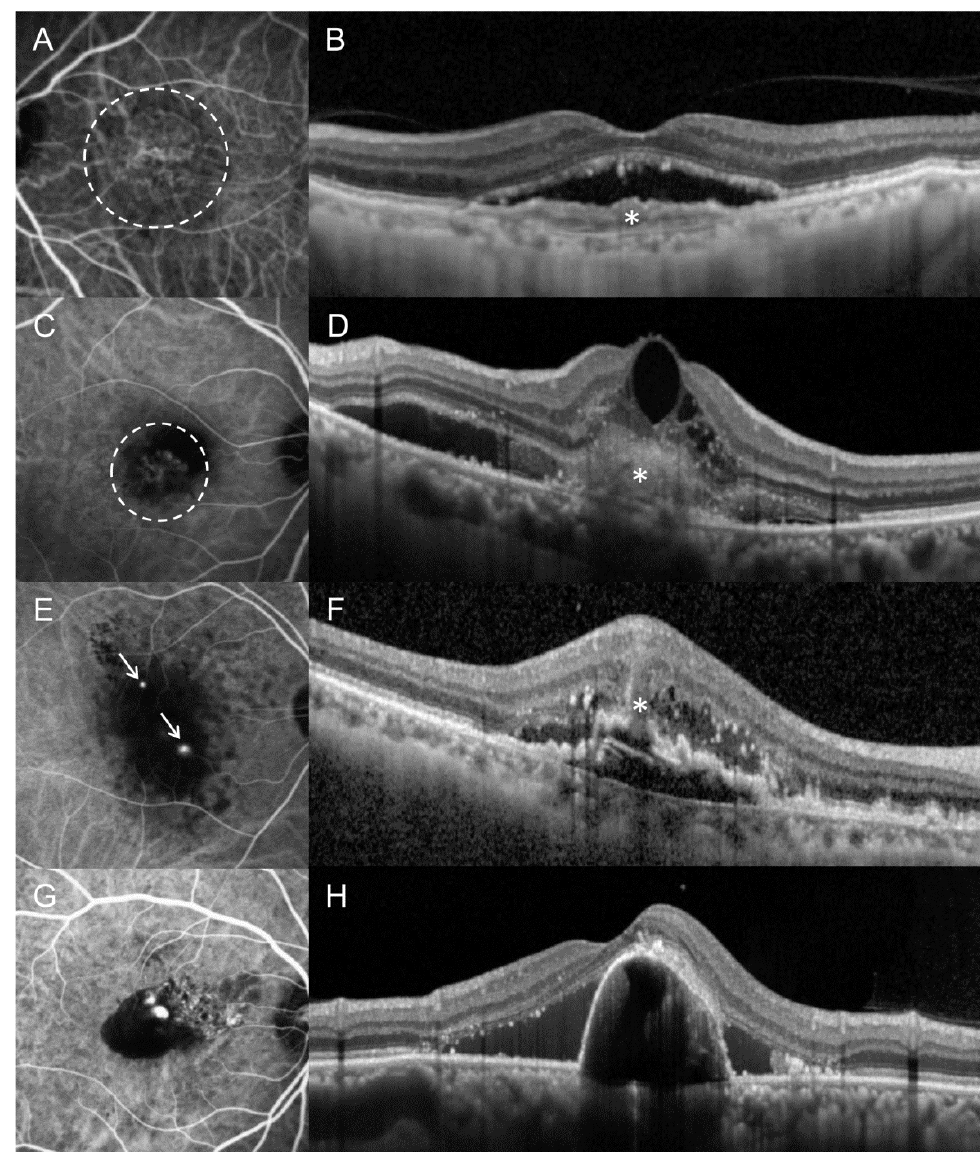
Figure 1. Representative indocyanine green angiography (ICGA) ( A , C , E , G ) and optical coherence tomography (OCT) ( B , D , F , H ) images showing representative cases of type 1 macular neovascularization (MNV) ( A , B ), type 2 MNV ( C , D ), type 3 MNV ( E , F ), and polypoidal choroidal vasculopathy (PCV) ( G , H ). In type 1 MNV, a neovascular complex, observed on ICGA ( A , dashed circle), is confined to the sub-retinal pigment epithelium ( B , asterisk). In type 2 MNV, a neovascular complex was noted on ICGA ( C , dashed circle), accompanied with subretinal hyperreflective materials on OCT ( D , asterisk). In type 3 MNV, focal hyperfluorescent lesions are observed on ICGA ( E , arrows). On OCT, an intraretinal lesion with medium to high reflectivity was noted, accompanied with intraretinal edema and disruption of retinal pigment epithelial layer ( F , asterisk). In PCV, polypoidal lesions, observed on ICGA ( G) , are accompanied by prominent serous pigment epithelial detachment and subretinal fluid, observed on OCT ( H